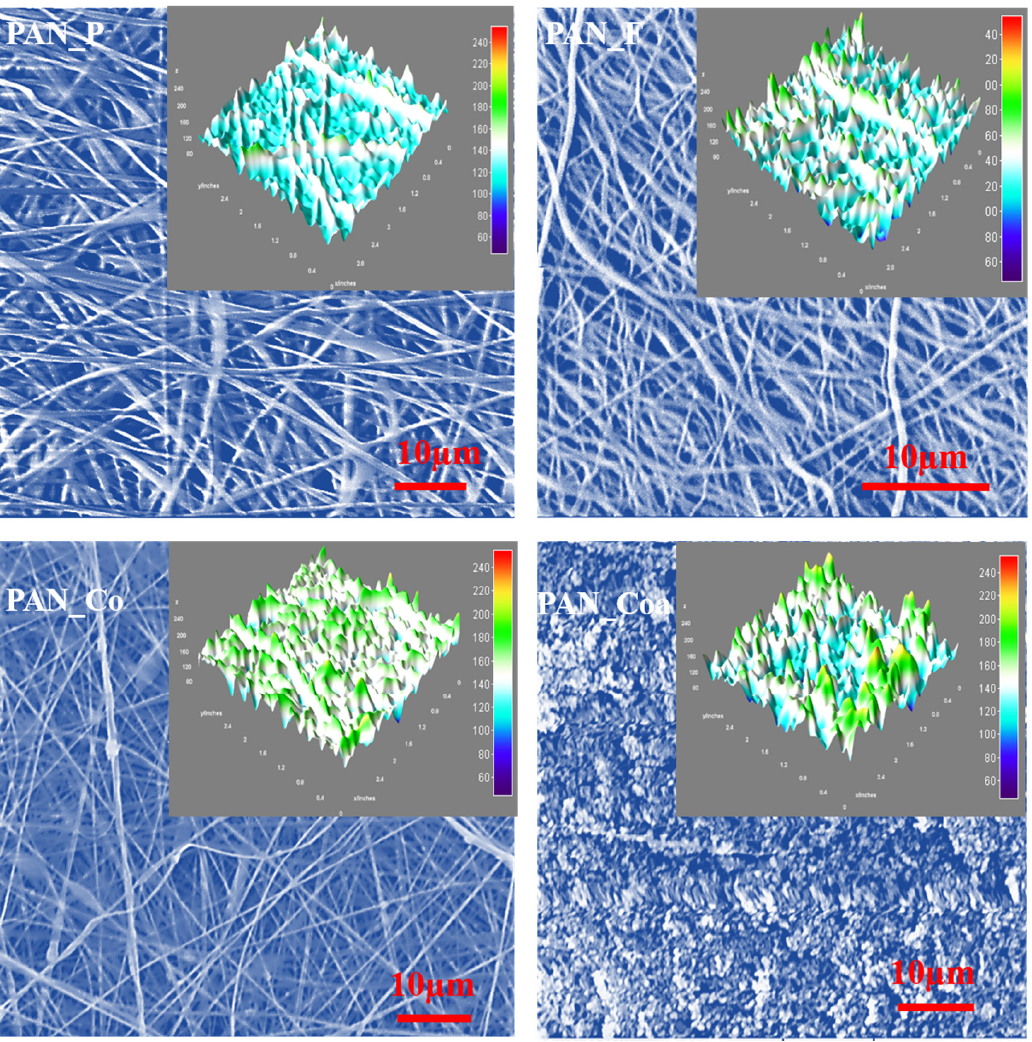
Figure 1. SEM micrographs of the PAN_P, PAN_F, PAN_Co and PAN_Coa NFs membranes. The 3D surface plots of the same are shown in the inset.